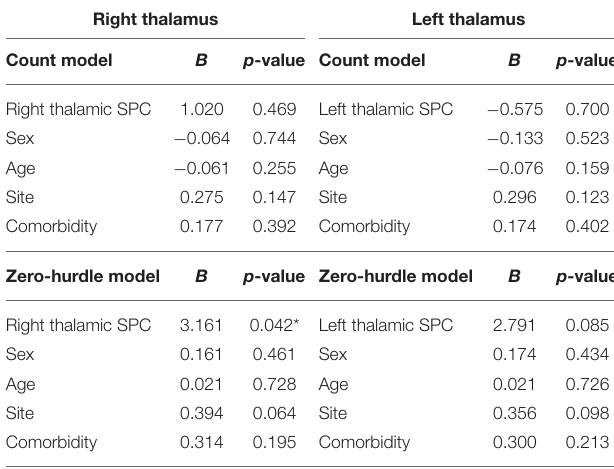
relationship between OCS and thalamic SPC. Right